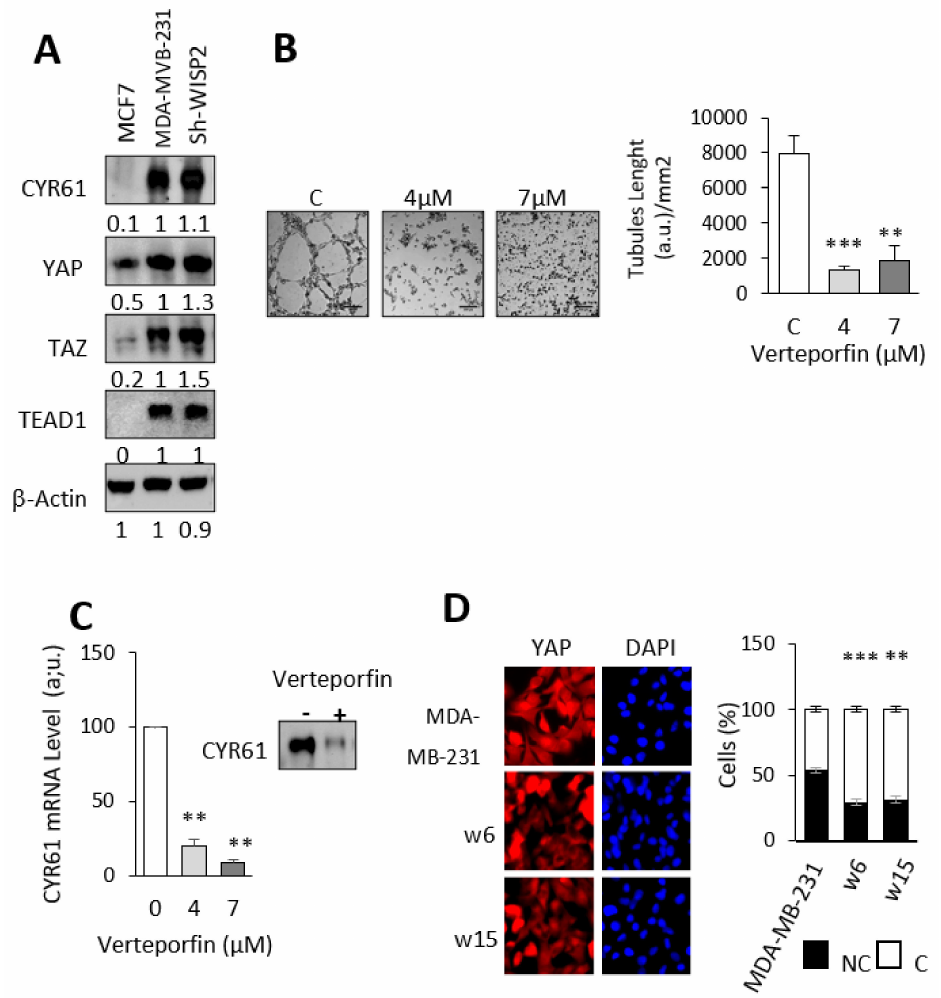
Figure 5. WISP2 regulates the Hippo/Yap pathway. ( A ) Representative Western blot analysis of Hippo/Yap markers in the different breast cancer cell lines. β -Actin was used as loading control; Levels of proteins were calculated by densitometry and listed beneath the bands. ( B ) MDA-MB- 231 cells were treated with 4 and 7 µ M of Verteporfin for 24 h and subjected to tube formation assay for 24 h. Length of tubes was measured; Scale bar = 200 µ m. ( C ) CYR61 mRNA expression was detected by qRT-PCR and secreted protein by Western blotting in the MDA-MB-231 cell line treated with verteporfin; ( D ) Representative images of YAP immunostaining in the MDA-231-cell line and in MDA-MB-231 cells stably transfected with WISP2 (clone w6 and w15). YAP subcellular localization was quantified and reported as labeling observed in nucleus and cytoplasm (NC; Black) or in cytoplasm alone (C; White). Results were obtained in three separate experiments in which 4 images corresponding to 200 cells approximately were examined. All data are represented as ± SEM. ** p < 0.01; *** p < 0.005. The original western blots can be found in File